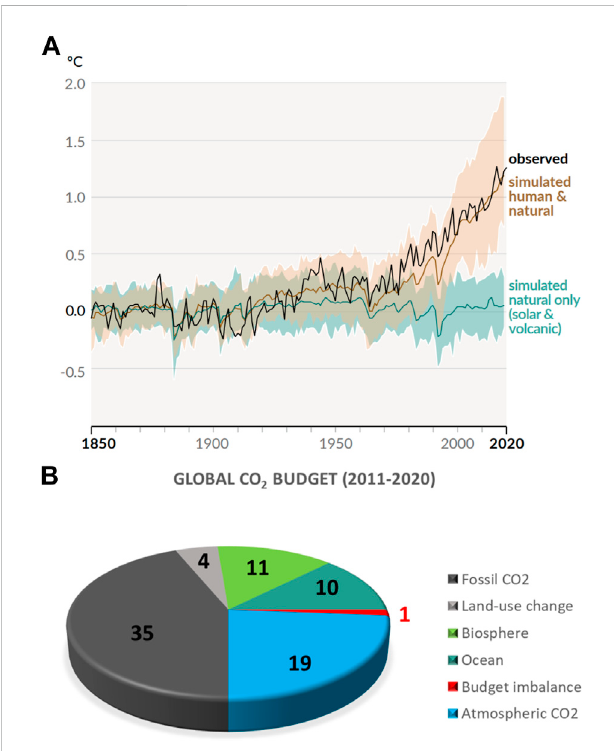
FIGURE 1 (A) . Changes in global surface temperature over the past 170 years (black line) compared to climate model simulations of human and natural drivers (brown line), and to only natural drivers (green line). Colored shades show the likely ranges. Reproduced from the sixth assessment report of the Intergovernmental Panel on Climate Change (IPCC, 2021). (B) . Global Carbon Budget 2021 (Friedlingstein et al., 2022) illustrated as a pie chart. Fossil and land-use CO 2 sources shown in gray tones. Biosphere and Ocean CO 2 sinks shown in green colors. Atmospheric CO 2 shown in blue. CO 2 budget imbalance due to measurement errors shown in